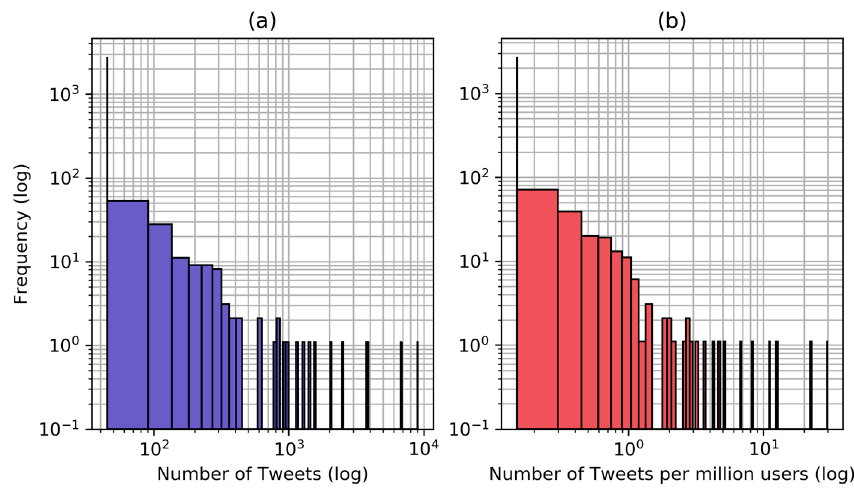
Figure 4. Histograms representing the distribution of the number of tweets per day ( a ) and the number of tweets per day per million users ( b ).